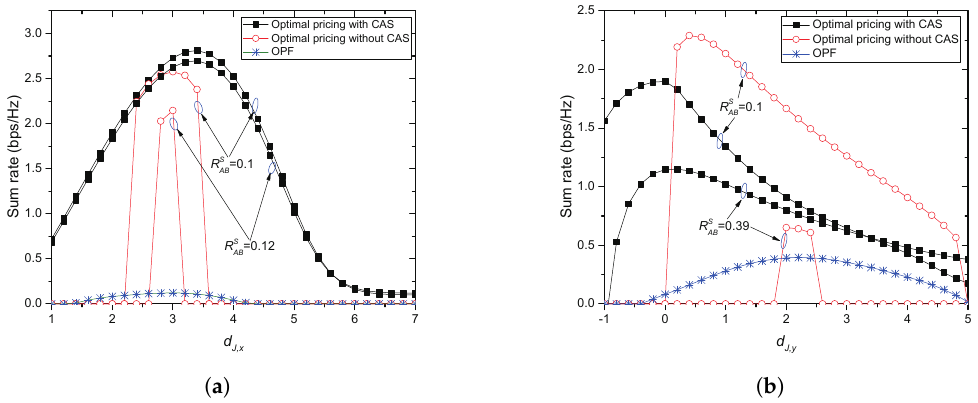
Figure 10. Comparison of sum-rates with a single jammer. ( a ) The jammer moves horizontally; ( b ) the jammer moves